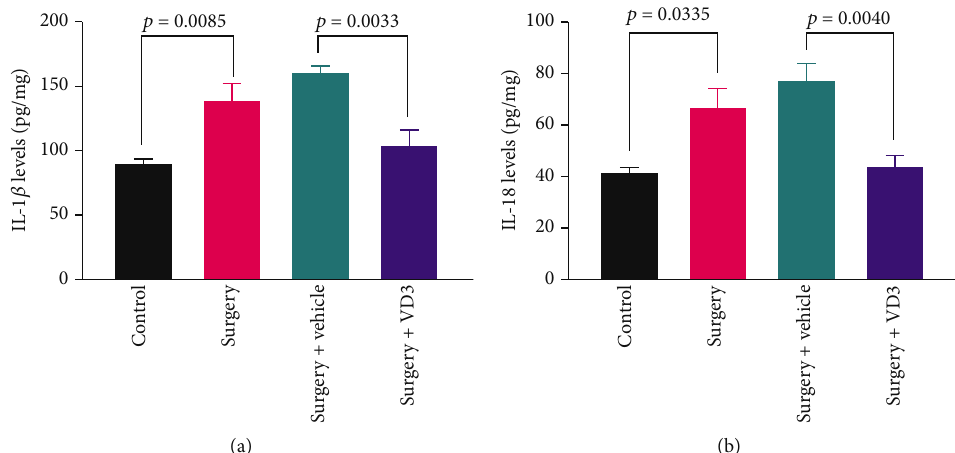
Figure 5: Hippocampal neuroin fl ammation following surgery. IL-18 and IL-1 β protein expressions in the hippocampus. Data are presented as means ± SD ( n = 6 per